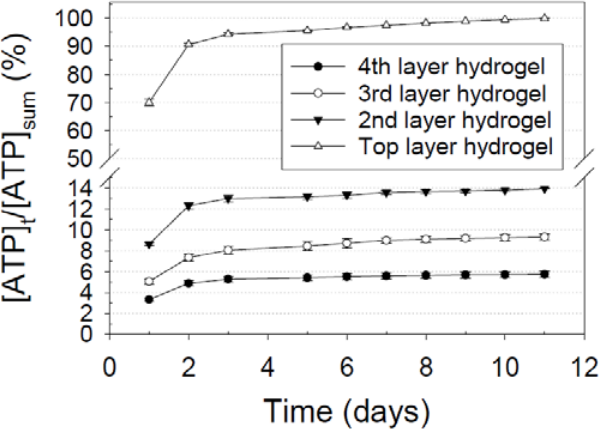
Figure 4. Release kinetics of ATP from a designated layer of the multilayer nanofiber-hydrogel meshes: Release from the top layer hydrogel of an eight-layer nanofiber-hydrogel